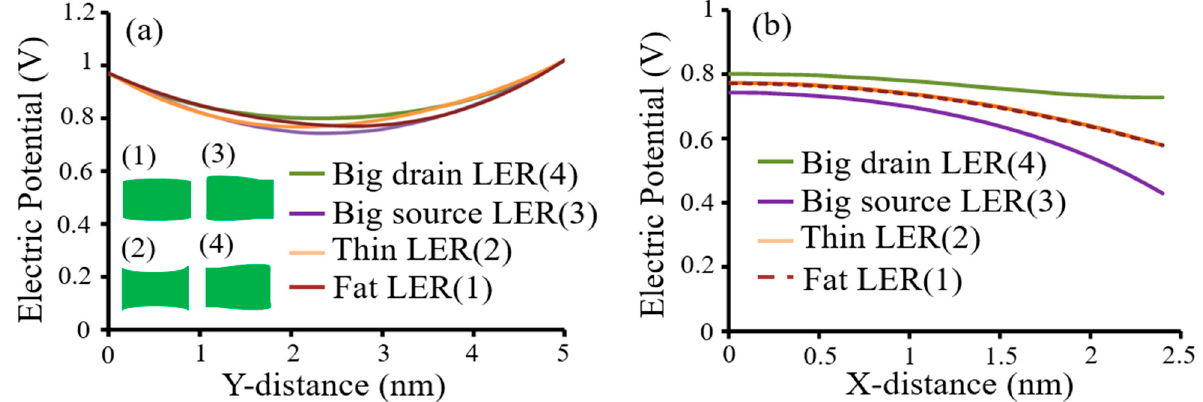
Figure 7. Analytical results: ( a ) electric potentials ϕ 1 (0, y ) for a FinFET with FWRs; ( b ) electric potentials ϕ 1 ( x , L /2 )